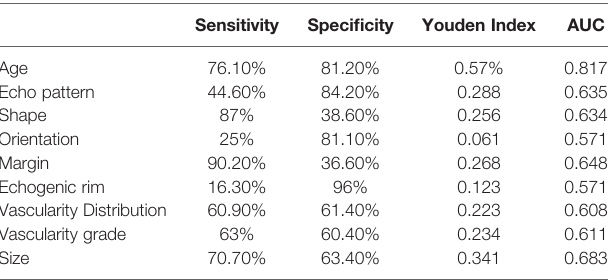
TABLE 2 | Sensitivity, speci fi city, and Youden index of nine features for differentiating MBC from